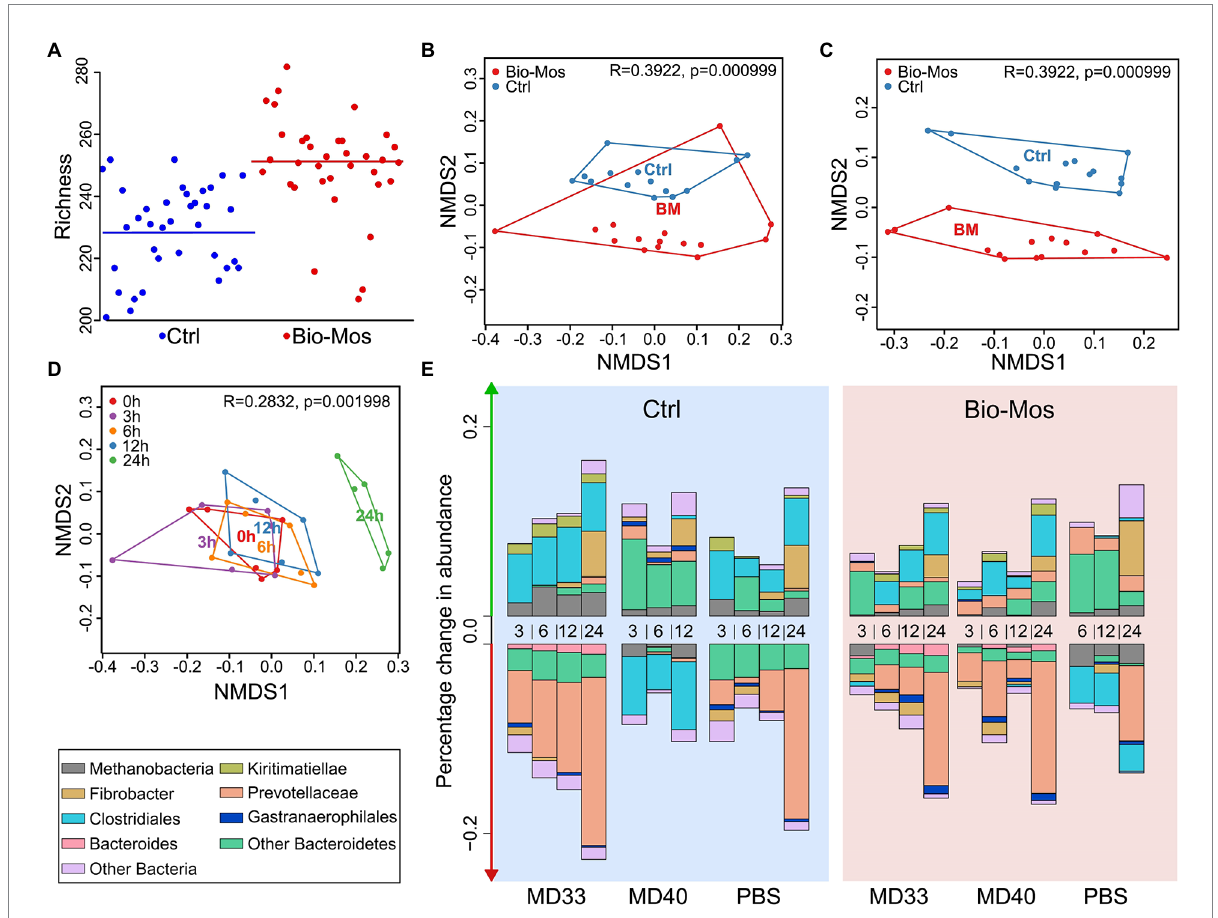
FIGURE 2 Ex vivo community analysis of the prebiotic effect of Bio-Mos®. (A) Richness plot showing number of bacterial genera alpha-diversity represented in each sample. (B) Non-metric Multi-dimensional Scaling (NMDS) plot comparing microbial communities of rumen samples extracted from cannulated cattle fed Control (blue) or Bio-Mos® (red) diets. There was a significant difference in the microbial community composition between these diets. (C) Difference in Bacteroidetes read abundance between rumen Control (blue) and Bio-Mos® (red) rumen communities. (D) NMDS plot comparing composition of microbial communities collected from artificial rumen systems at different time points. 0 h in red; 3 h in purple; 6 h in orange; 12 h in blue; and 24 h in green. The composition of the community at 24 h was significantly different than all other time points. 0, 3, 6, and 12 h communities showed no significant difference in their composition. (E) Percentage change in abundance of different taxonomic groups in artificial rumen communities. Diet (Control in blue, or Bio-Mos® in red background), Probiotic treatment (MD33, MD40, or control), and sample time point (3, 6, 12, or 24 h) shown on the x